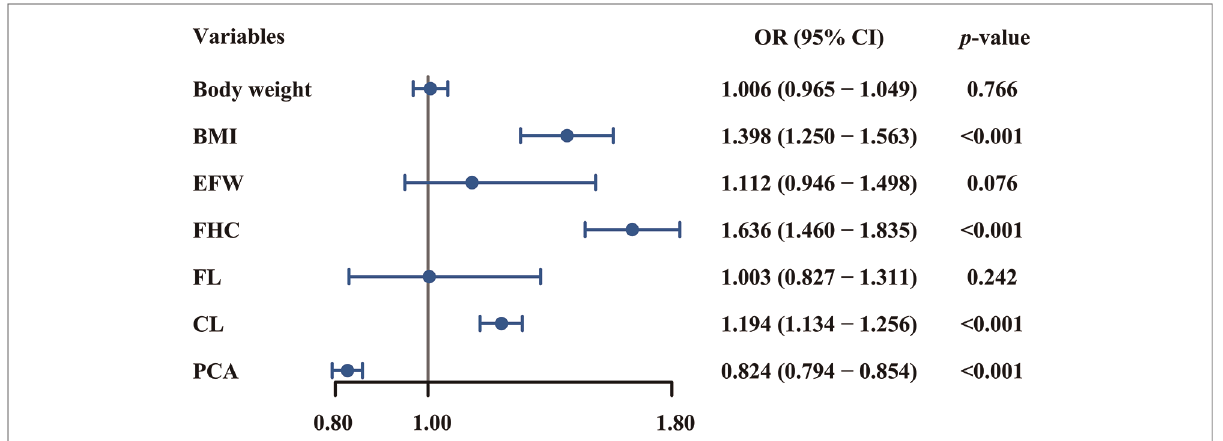
FIGURE 3 Forest plot of multivariate logistic regression analysis for the correlates of SVD failure. BMI, FHC, CL, and PCA were independently associated with SVD failure (all p- values <0.05). SVD, spontaneous vaginal delivery; BMI, body mass index; FHC, fetal head circumference; CL, cervical length; PCA, posterior cervical angle; OR, odds